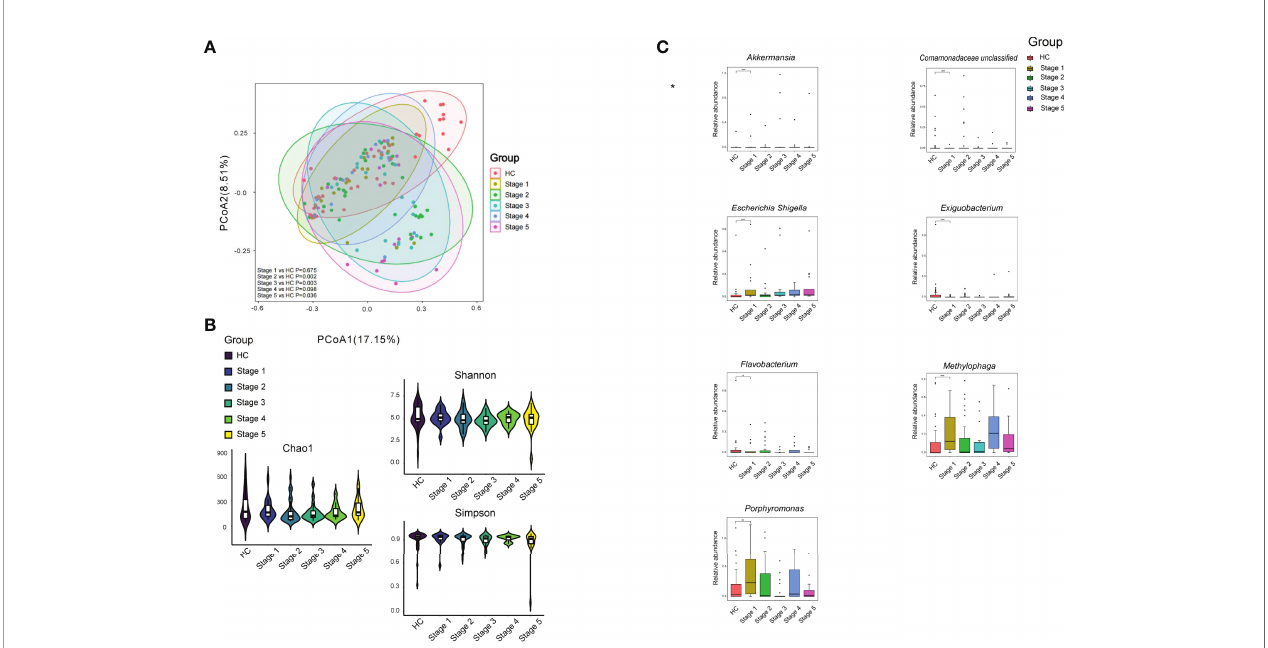
FIGURE 3 | Bacterial community, diversity, and genus comparison in the subgroups according to CKD stages and HC. (A) PCoA based on Bray – Curtis distances at ASV level showed different microbial compositions between subgroups of CKD stage and HC. Permutational multivariate analysis of variance (PERMANOVA) was performed for statistical comparisons of samples in the six groups. p -value was adjusted by the Benjamini and Hochberg false discovery rate (FDR). (B) Bacterial richness and diversity measured by Chao1, Shannon, and Simpson were calculated at the microbial ASV level. Wilcoxon rank-sum test was performed and adjusted by Benjamini and Hochberg false discovery rate (FDR). (C) Comparison of the abundances of bacterial genus in CKD patients in each stage and HC. * p < 0.05, ** p < 0.01, and *** p < 0.001,